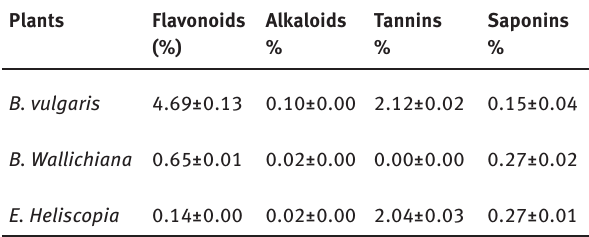
Table 6: Quantitative estimation of medicinally important secondary metabolites in the plant taxa studied.